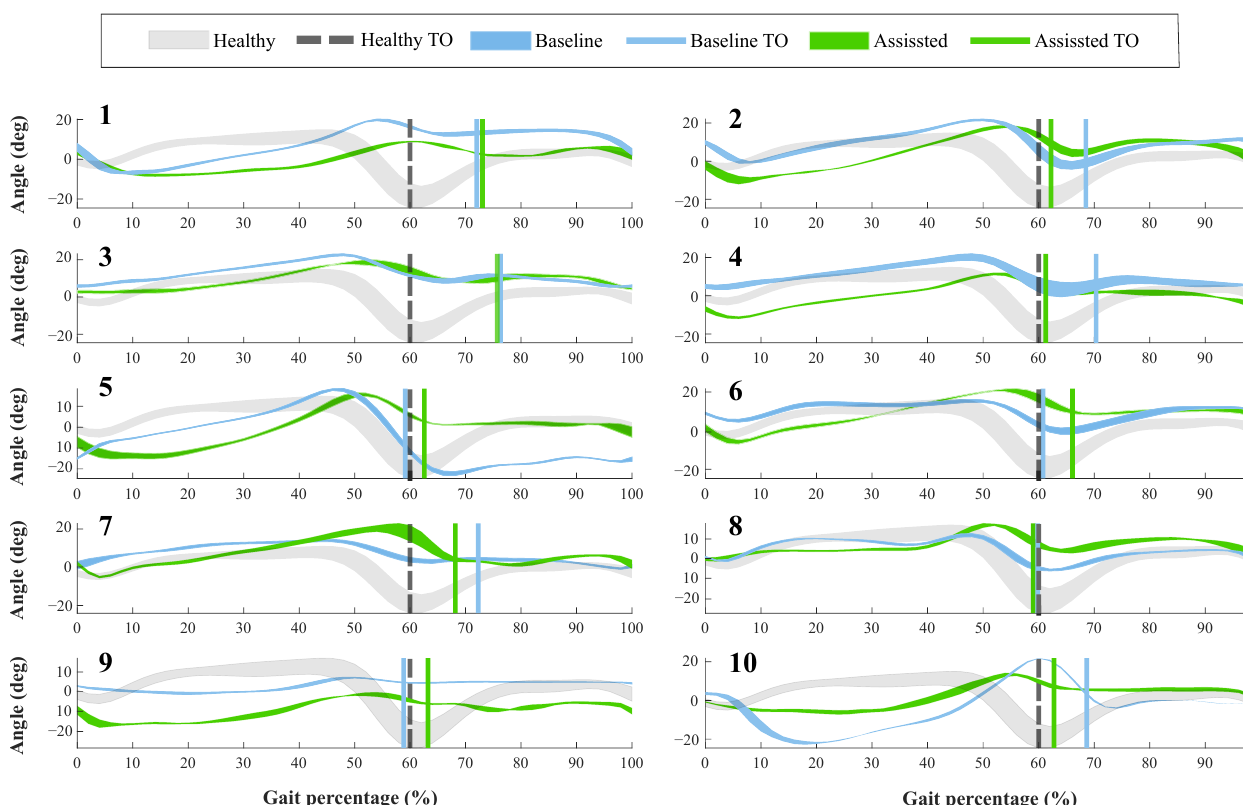
Figure 4. Volunteers’ ankle kinematics during the gait cycle. Numbers on the left part represent the assessed participants. The green curve indicates the assisted gait condition. On the other hand, the blue curve refers to the natural gait pattern (i.e., baseline condition). The gray curve shows a healthy gait pattern obtained from a database of people with no pathological gait available in Figshare at a public repository (https://doi.org/10.6084/m9.figshare.12576965.v1 (accessed on 27 June 2020)). Finally, the vertical lines describe the Toe-Off event (TO) for each of these